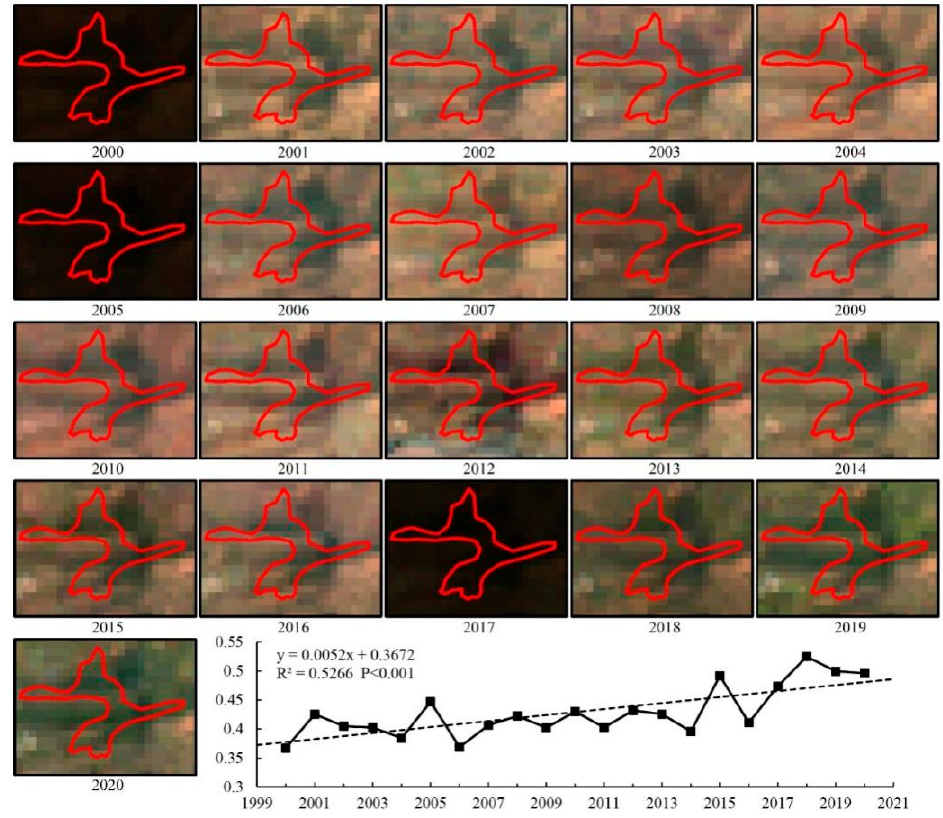
Figure 6. Landsat RGB composite images and inter-annual variations in vegetation MODIS NDVI in a project area of cultivated land returning to forest during